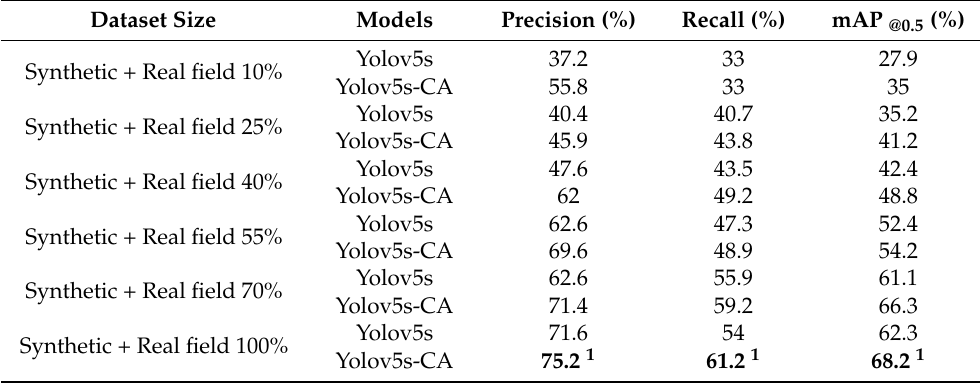
Table 3. Performance comparison of the model trained on a combination of synthetic and real field